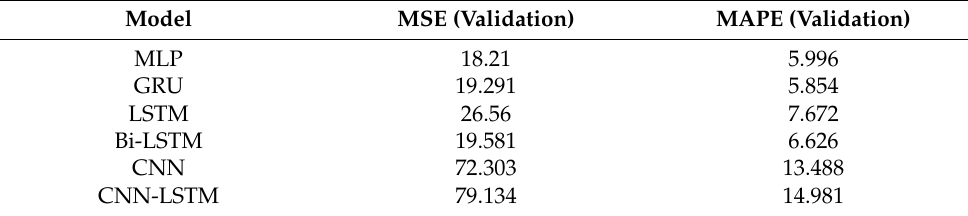
Table 17. The validation results of the models using ExxonMobil data with six input